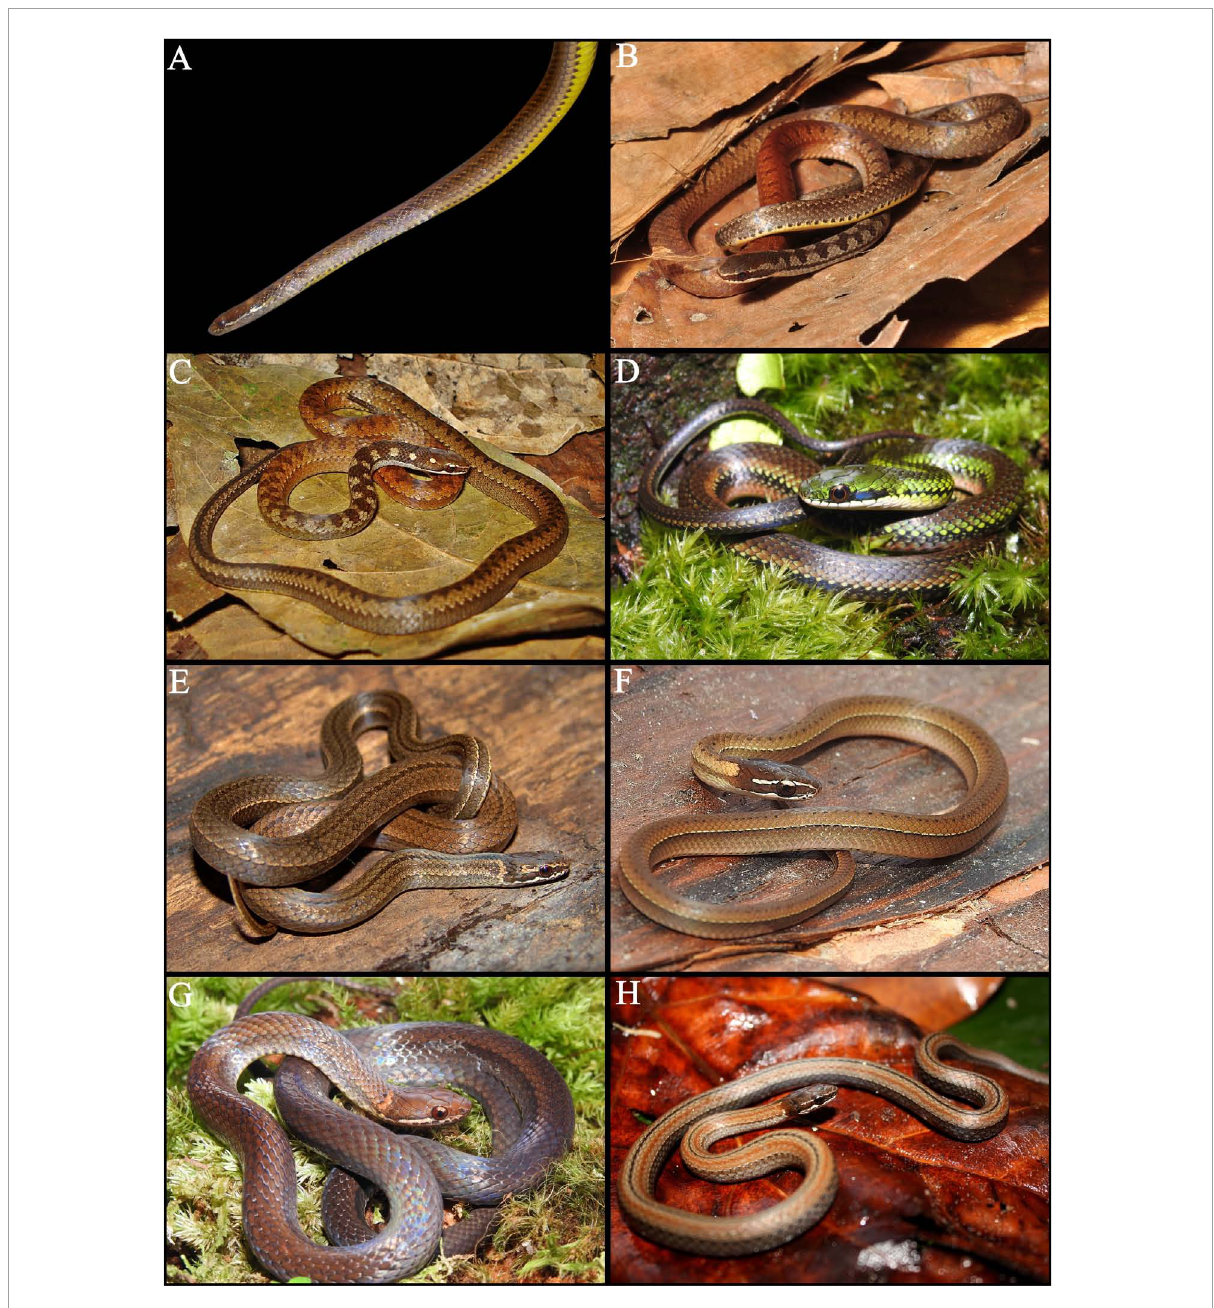
FIGURE3 General morphological aspects of some species representing the diversity of the genera Myersinia , Adelphostigma , Amnisiophis and Dibernardia . (A) Myersinia nebularis ; (B) Adelphostigma cf. occipitalis ; (C) Adelphostigma quadriocellata ; (D) Amnisiophis amoenus ; (E) Dibernardia affinis ; (F) Dibernardia bilineata ; (G) Dibernardia persimilis ; and (H) Dibernardia poecilopogon .